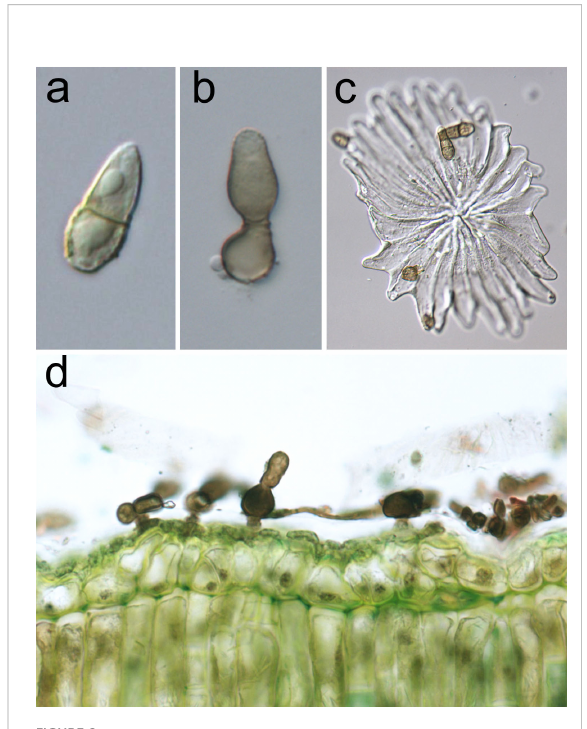
FIGURE 2 Venturia oleaginea anamorphic structures. (A) One-septate oval- pyriform conidium; (B) subglobose conidiophore producing a conidium at its apex, annellations are visible at the top of conidiogenous cell; (C) conidia on an olive peltate trichome (trichome represents an entry via as well as can function as parachute to spread the disease); (D) olive leaf section showing the presence of the mycelium in the cuticular